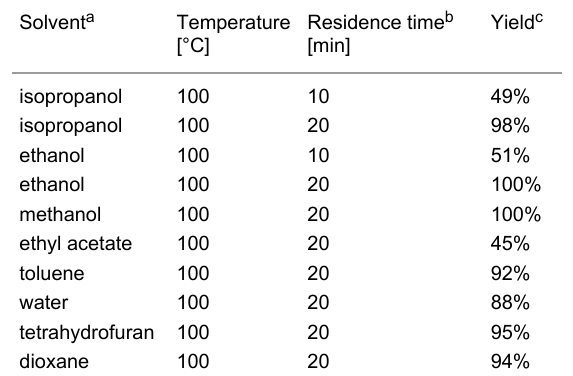
Table 1: Optimisation for the hydration of the pyrazine-2-carbonitrile. Reactions were performed with dry solvents and a fresh batch of cata- lyst for each. The reactions were carried out on a 1 mmol plug of pyrazinecarbonitrile such that the zirconia was present in